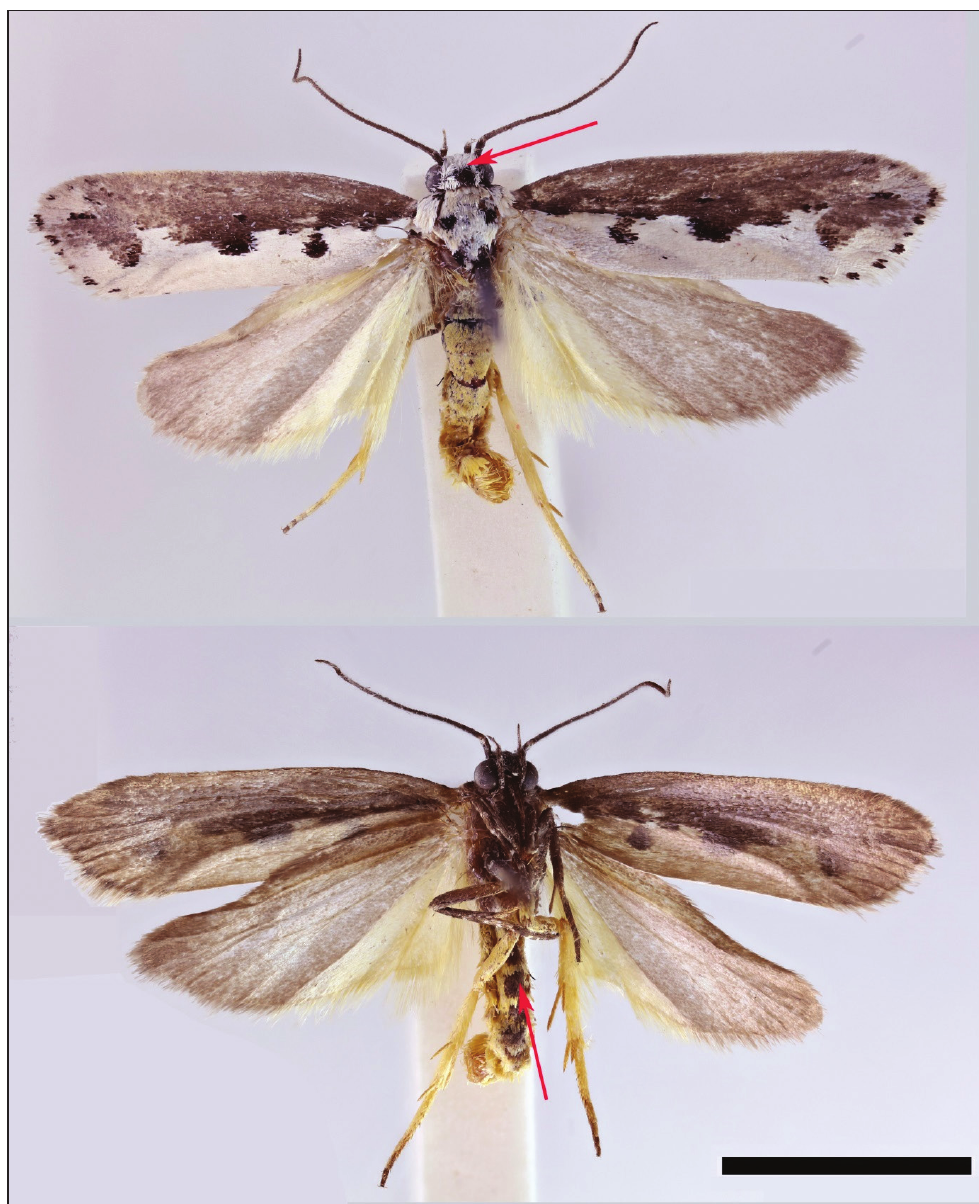
Figure 1. Ethmia iranella Zerny, ♂. Italy, Apulia, Lecce, Veglie, Torrelupomonaco, 7.vii.1961 ( Hartig ). NHMUK010862886. Top, dorsal view; bottom, ventral view. Red arrows mark black spot on vertex and ventral dark abdominal patches respectively. (Phot. David